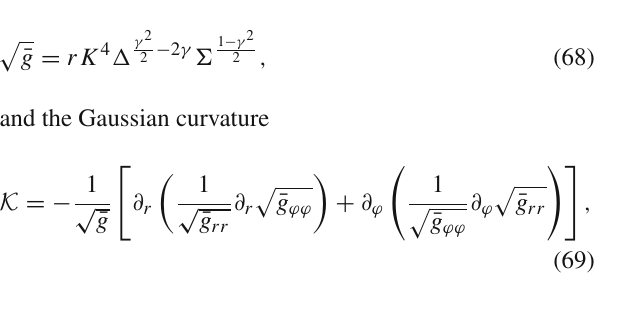
Fig. 11 Variation in the bending angle δ versus x is plotted for the compact object SAXJ1808.4-3658. The star is considered for the cases of uncharged stationary (ω (cid:8)= 0 ) , static charged ( q (cid:8)= 0 ) and static